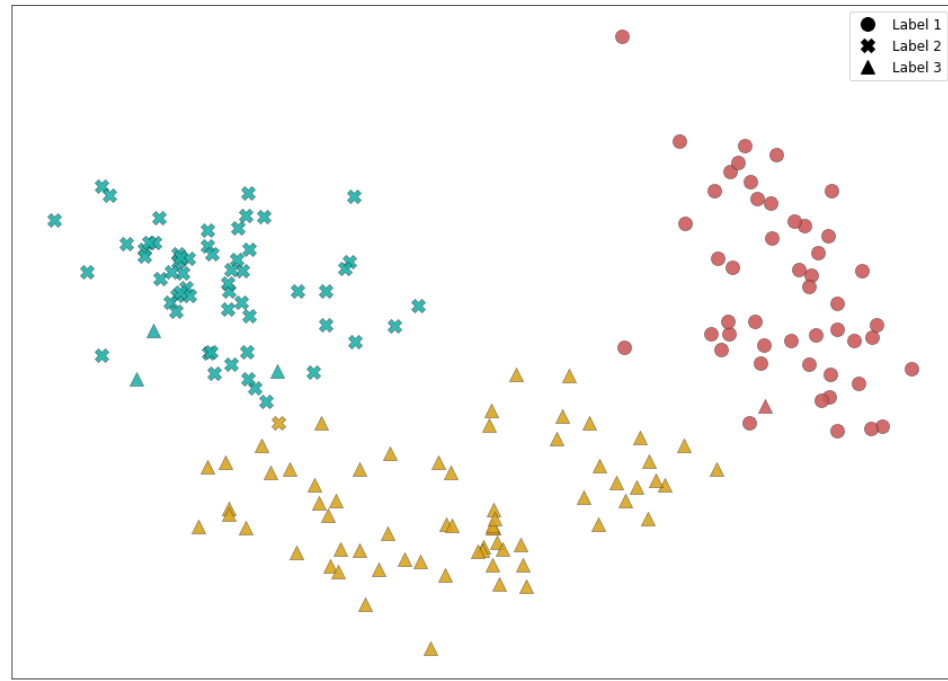
Figure 5. GMM clustering of the wine data set with Isomap dimension